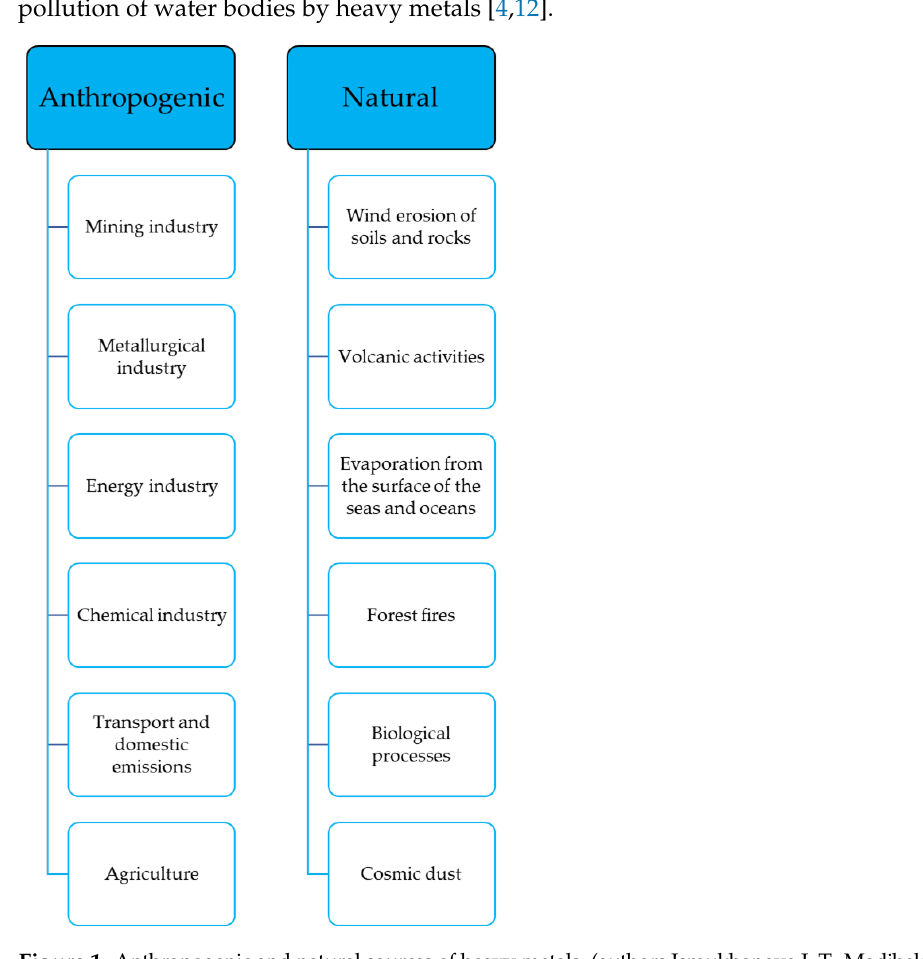
Figure 1. Anthropogenic and natural sources of heavy metals. (authors Ismukhanova L.T., Madibekov